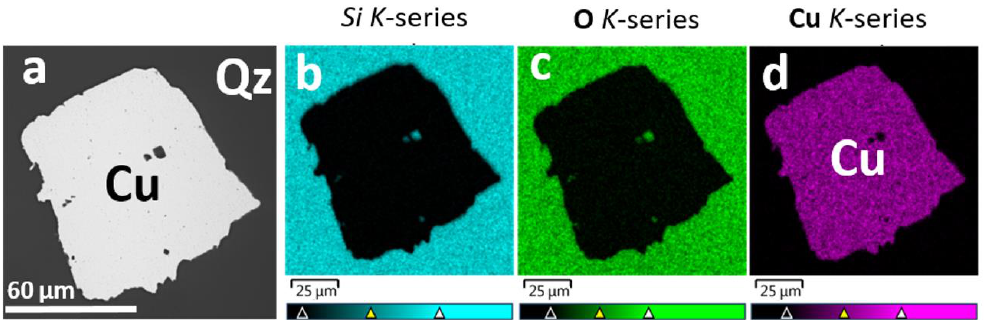
Figure 12. Native copper in a silica matrix: ( a ) SE micrograph, ( b – d ) distribution of elements over the scanning area from the thin section of agate No. 5 (Figure 4a,d).